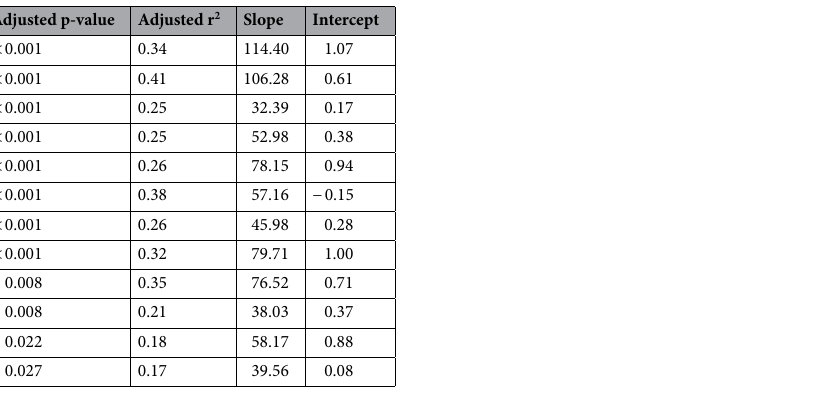
Table 3. Genes displaying significant correlations between relative expression and K trans across all